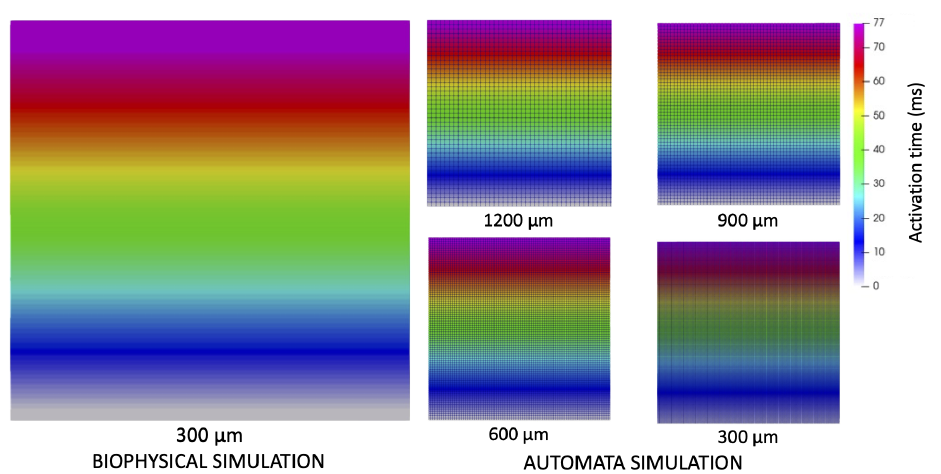
Figure 4. Comparison of activation time maps for biophysical and CA simulations. Results from simulation of a flat wavefront originating from the bottom of the 3D slab model and progressing in the Y-direction. Models are labeled as a function of the methods used to solve the electrical diffusion (biophysical or CA), and the resolution of the hexahedral elements (300 µ m to 1200 µ m). Colors represent the time in which a node activates from 0 to 77